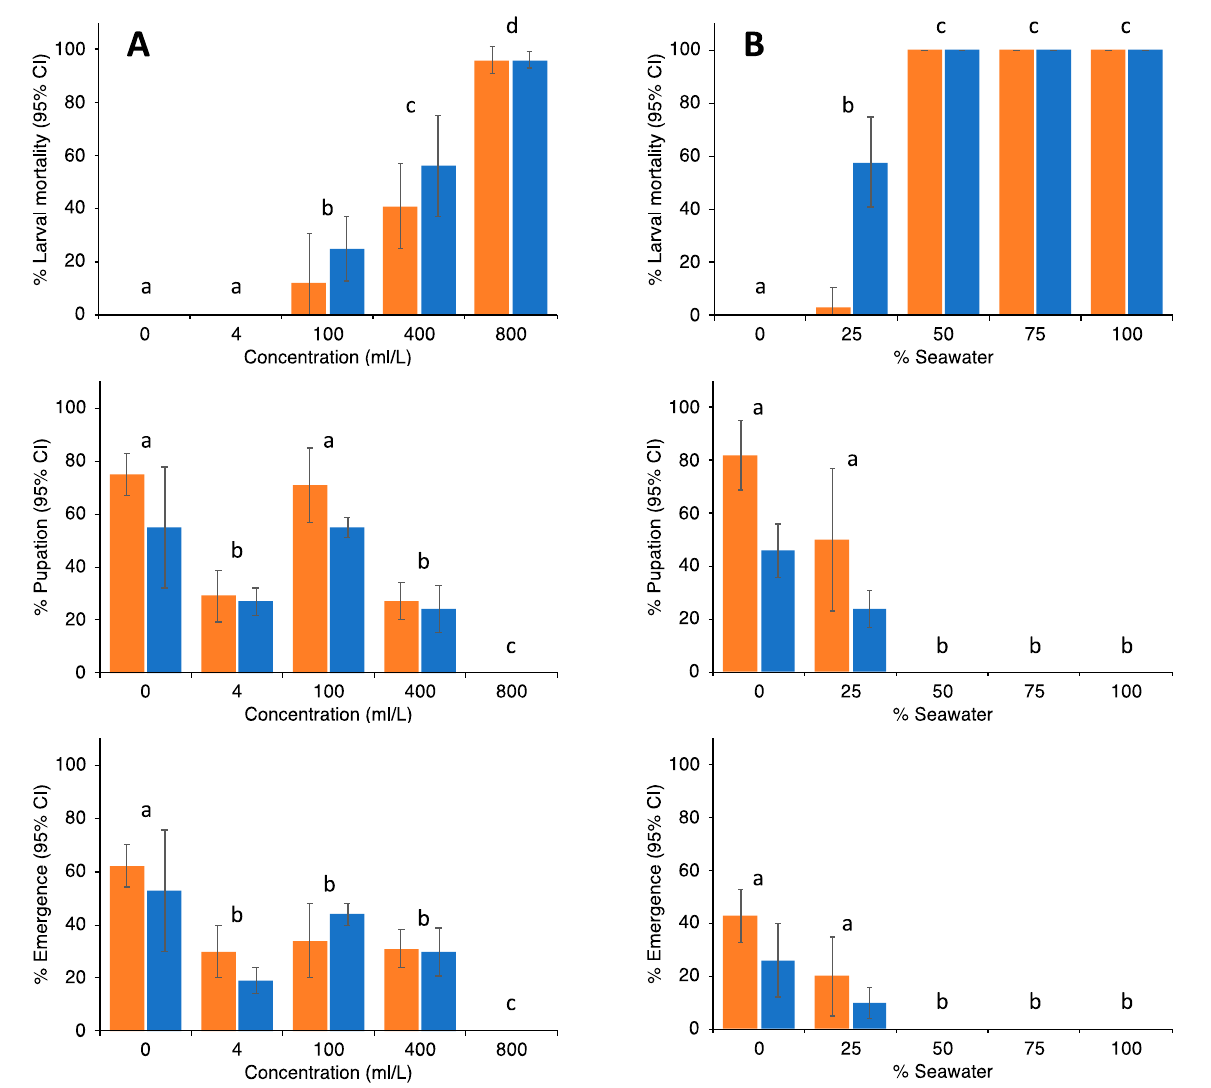
Figure 10. Percentage ( ± 95% CI) of larval mortality, pupation and emergence of Ae. albopictus (orange bars) and Cx. quinquefasciatus (blue bars) when exposed to different concentrations of neem oil (( A ), left graphs) or seawater (( B ), right graphs). No significant differences were observed between both mosquito species. Differences between treatments are indicated by letters; treatments with different letters are significantly different at p < 0.05 (Wilcoxon signed rank tests).